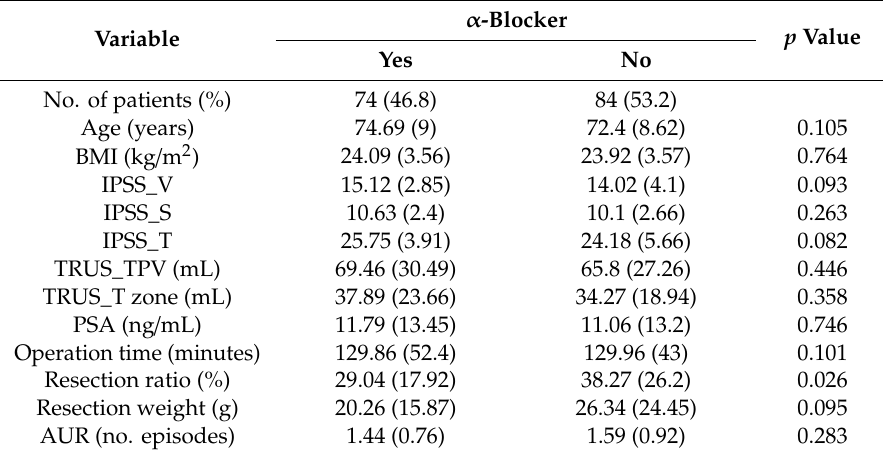
Table 4. α -blocker usage 3 months after